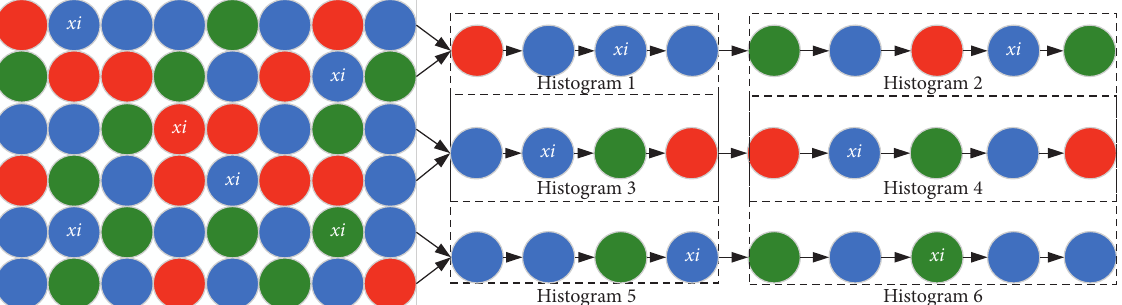
Figure 1: Mean shift fusion color histogram